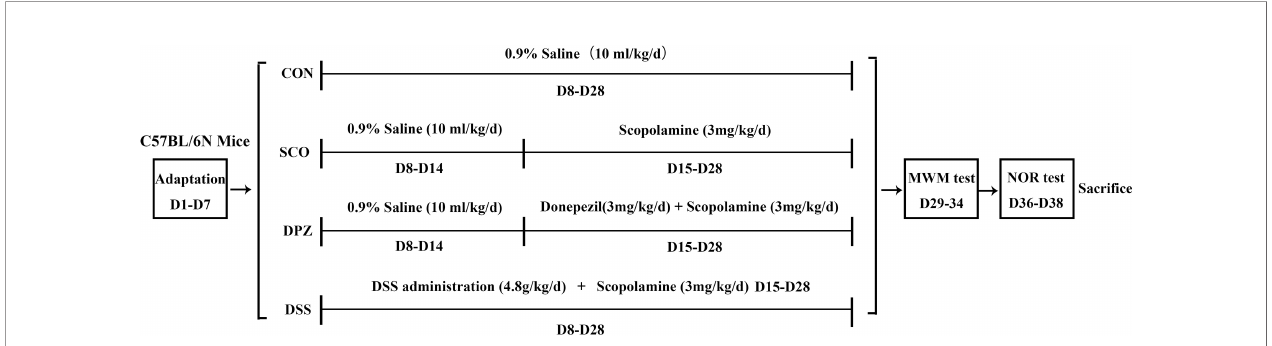
FIGURE 1 | The diagram for the experimental